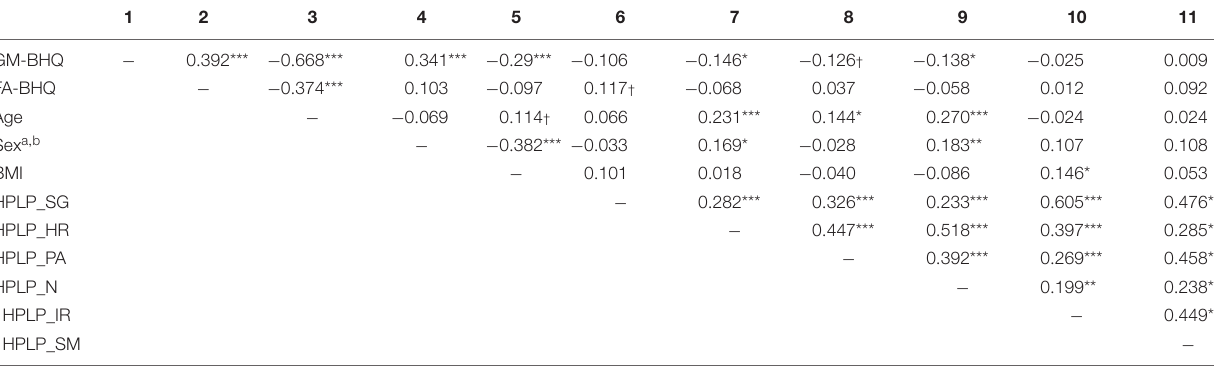
TABLE 2 | Correlation matrix.